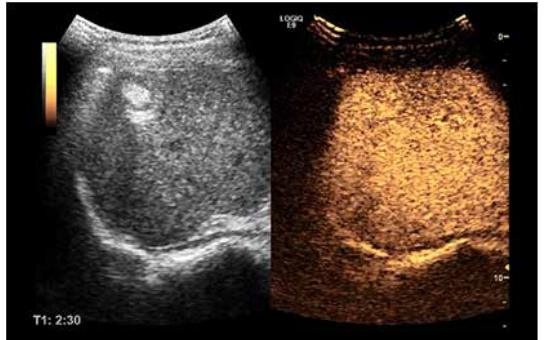
Figure 5 The final diagnosis was hepatic angiomyolipoma based on the histologic findings.